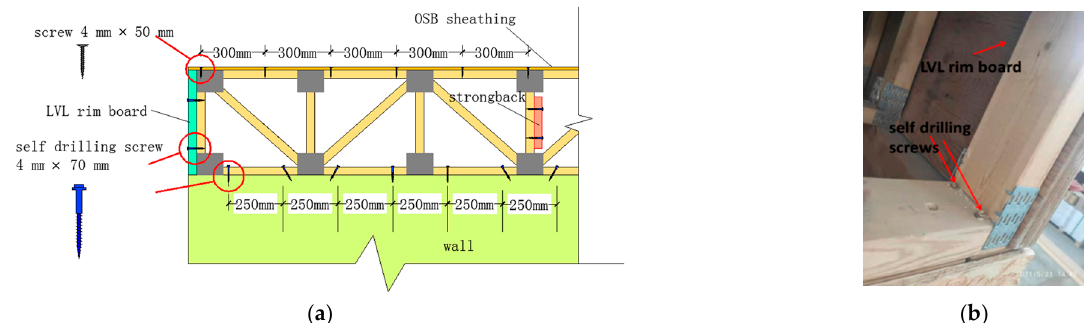
Figure 3. Connection details for the wood truss joist floor: ( a ) edge joists connecting to the framing walls; ( b ) the end of the joist connecting to the framing walls.